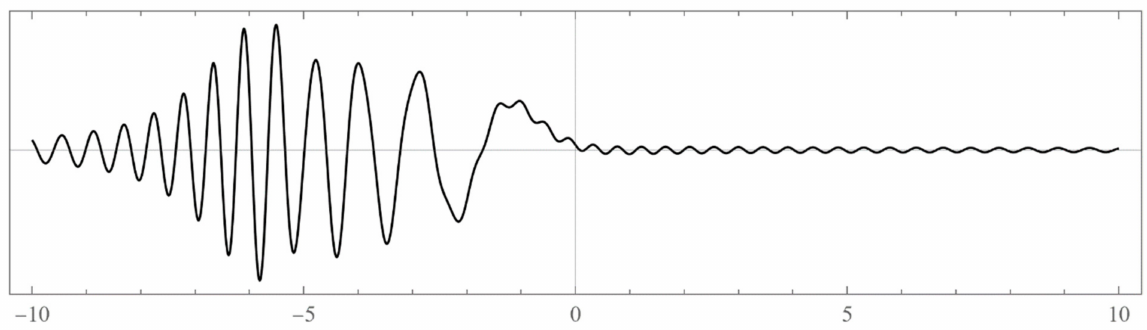
Figure A4. The un-normalized wavefunction (cid:101) ψ ( x , E ) for E = − λ 2 /2. We took N = 100.